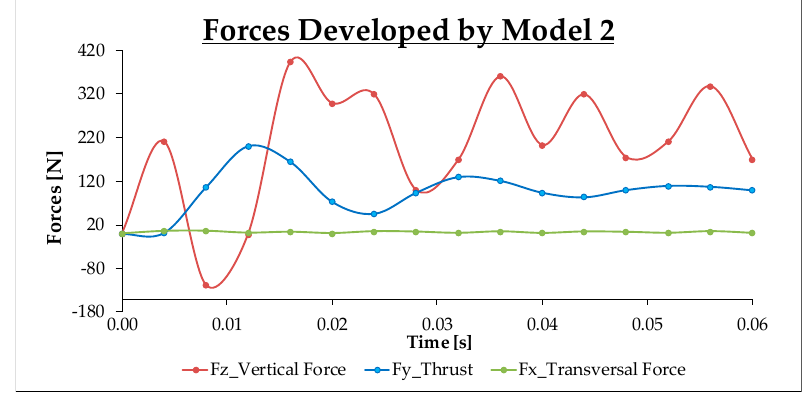
Figure 15. Forces in model 2.